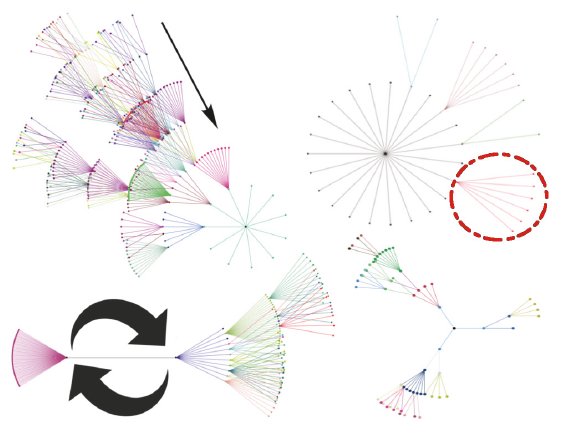
Figure 3: Excerpt of the attractor landscape. Fan-like represen- tation of a set of 4 attractors of the attractor landscape of the estrogen/estrogen receptor network. Each point represents a state of the network. Connections represent temporal succession between states, with the outward points representing preceding states (see black arrow). Same colored fans represent a collection of states that lead to the same future state of the network (e.g., red dashed circle). A cyclic attractor of size = 2 is also represented (see blue and purple circular arrows). The length of the connections is inconsequential as all time steps between states are